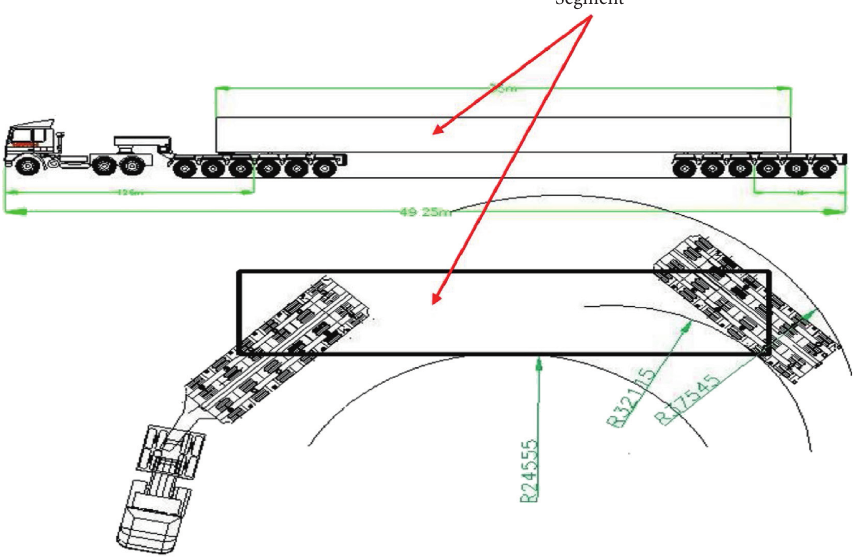
Figure 10: Working principles diagram of the steering